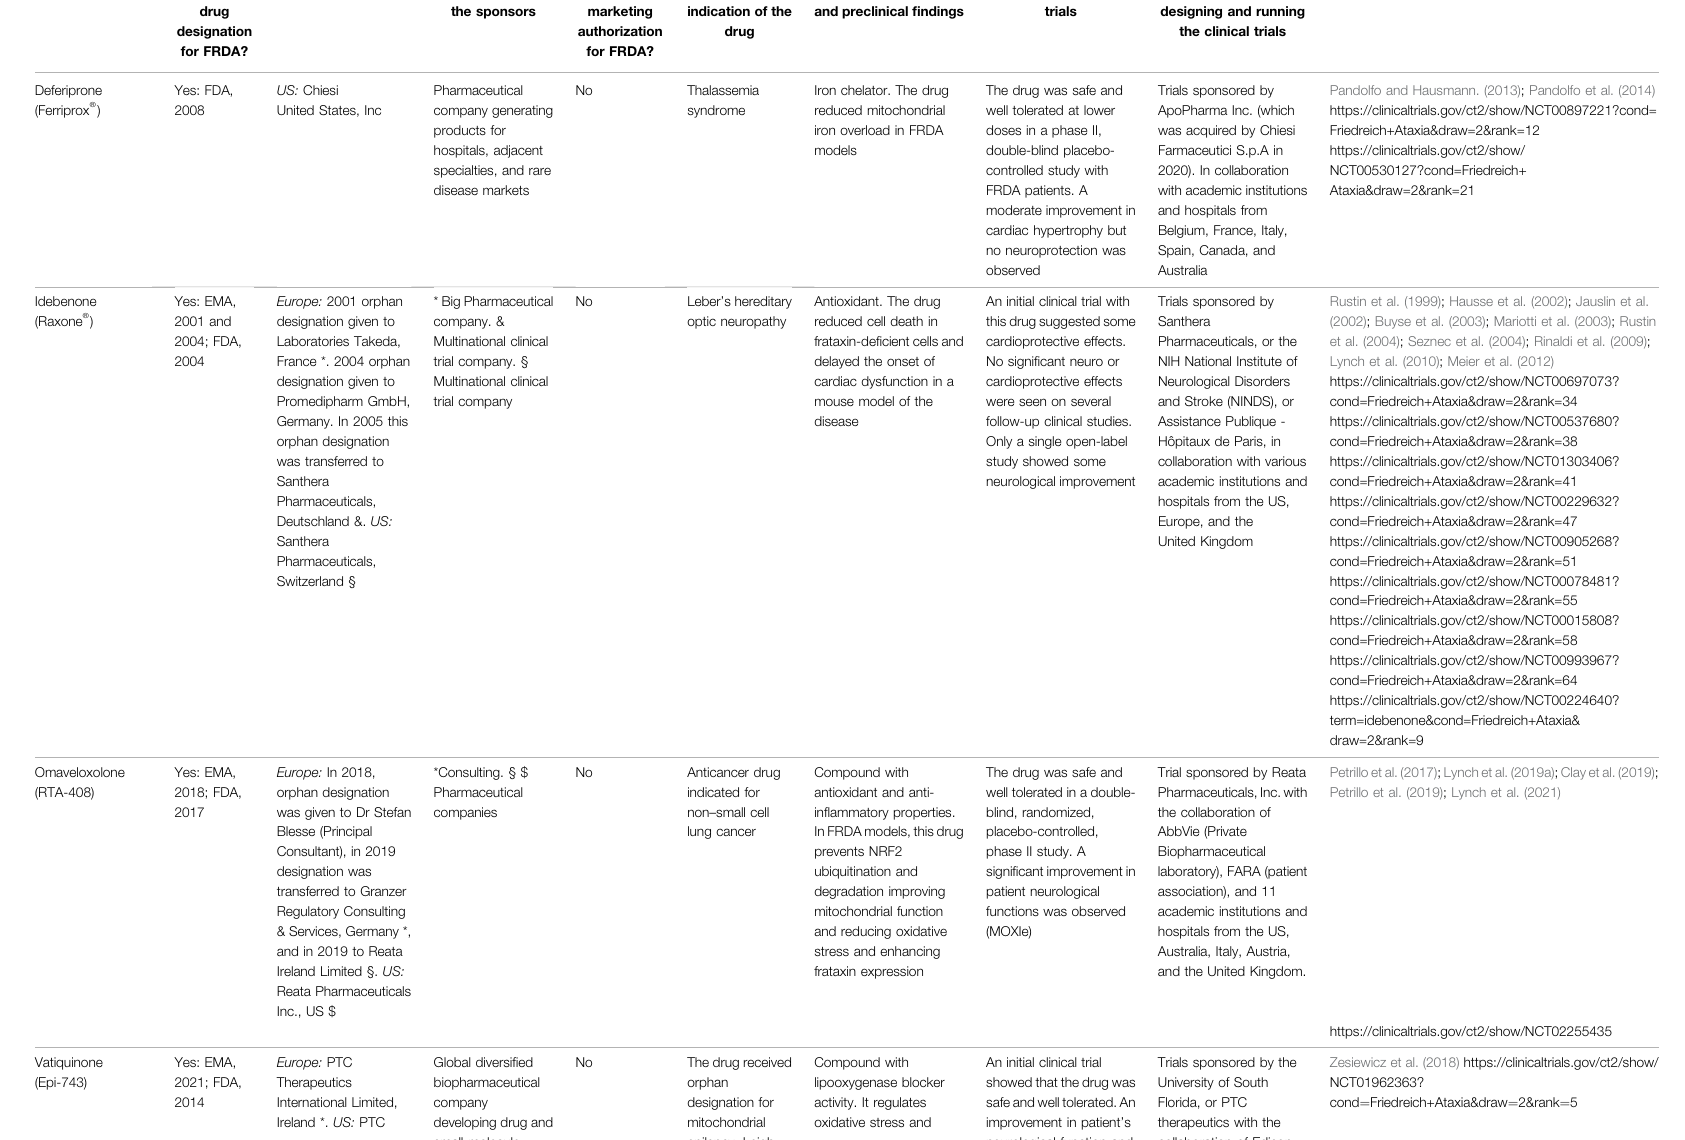
TABLE 2 | List of the repurposed drugs, with and without orphan designation or drug marketing authorization for Friedreich ’ s ataxia (FRDA) mentioned in this article. The sponsors (entities involved in making the orphan designation request to EMA or the FDA), and the public or private organizations involved in designing and running the clinical trials are detailed. N/A (cid:1) non-applicable. Drug name Orphan